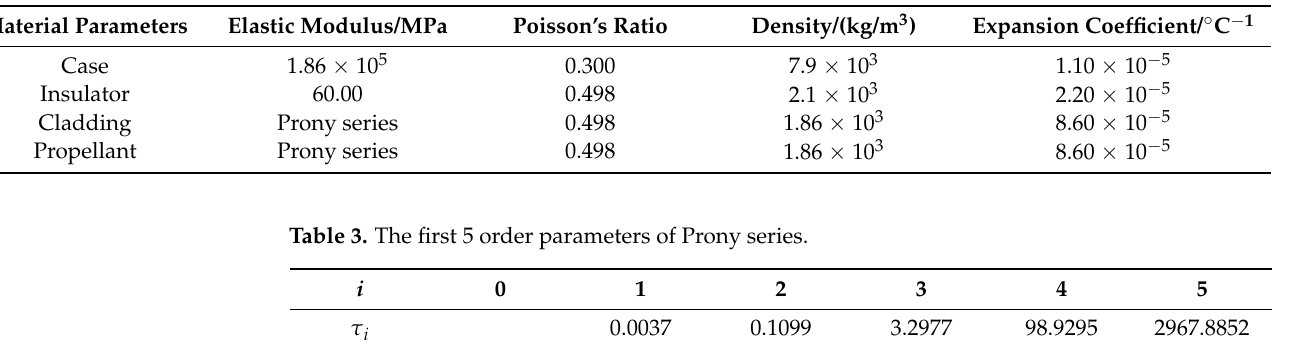
Table 2. Material parameters of the SRM.